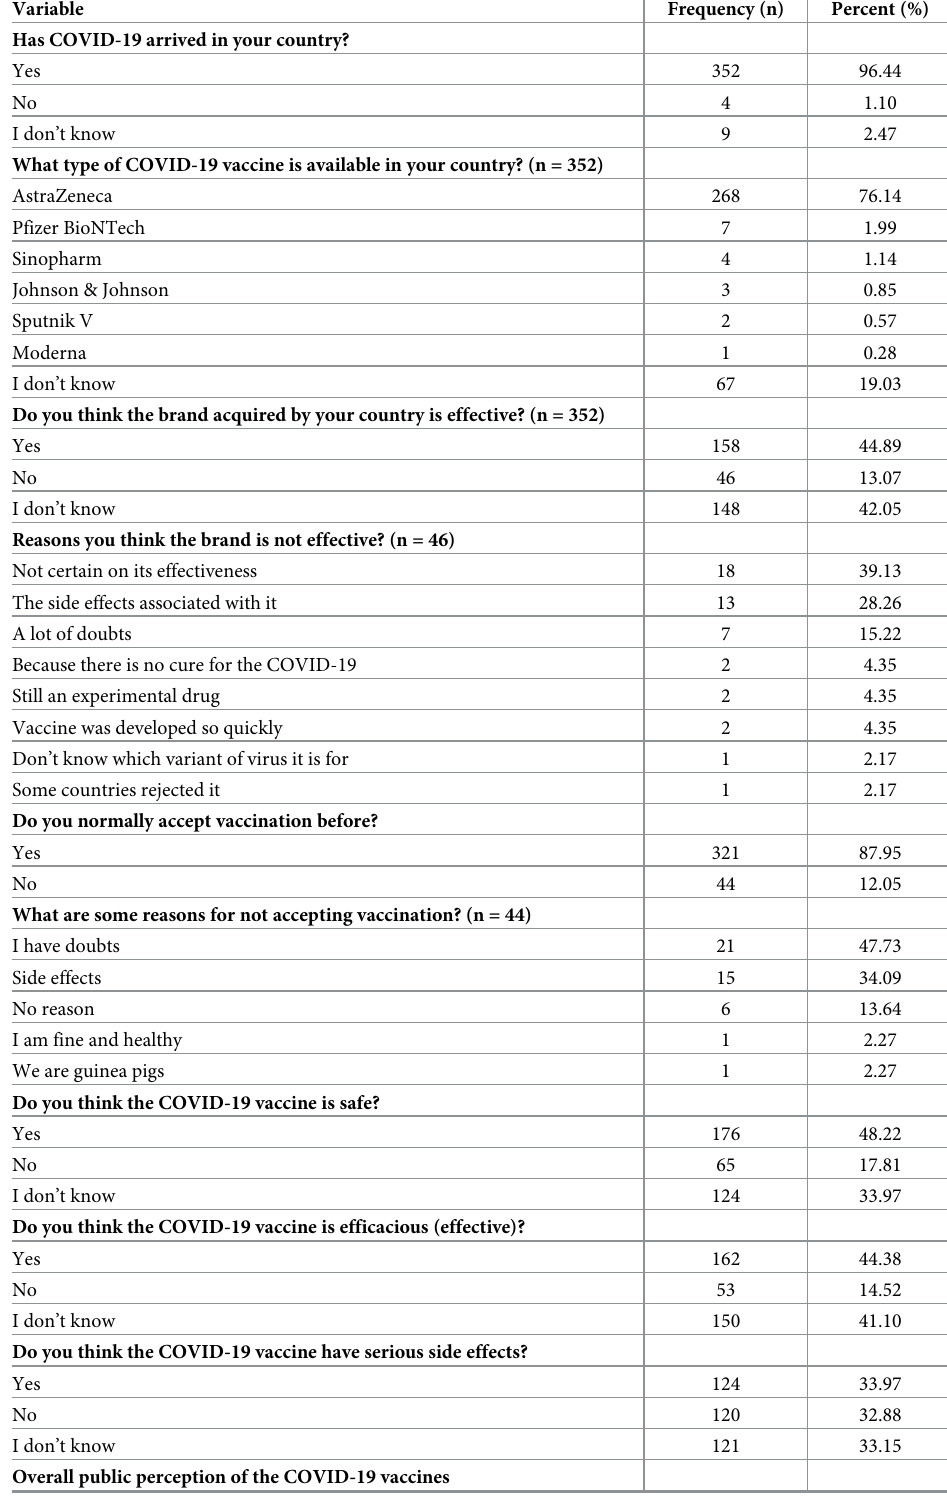
Table 4. Public perception on the COVID-19 vaccines (n =